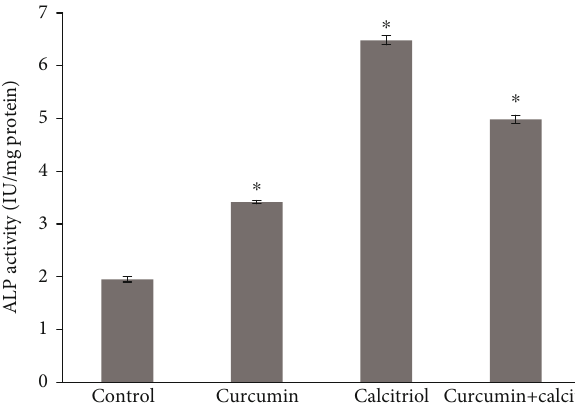
Figure 4: ALP enzyme activity on DPSCs treated with curcumin, calcitriol, and combination of them in 7